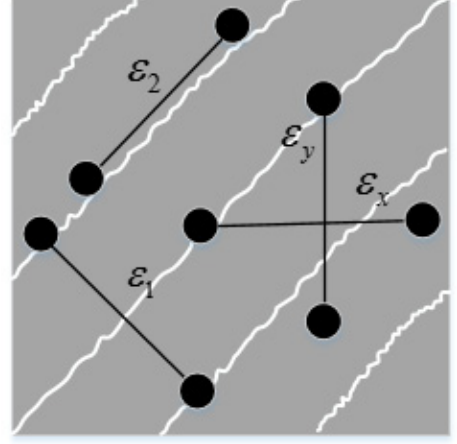
Figure 5. Strain of cracked concrete element.